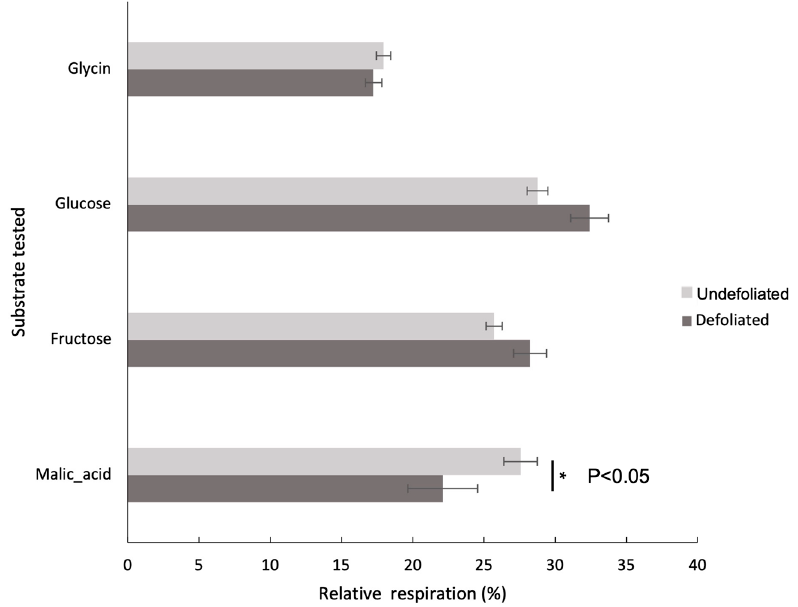
Figure 3. Relative respiration with ± standard error from four different carbon substrate-induced respirations of the top 5 cm of soil under undefoliated (N = 8 white) and defoliated (N = 6 black) Populus tremuloides trees. Tukey’s test found a significative difference between defoliated and undefoliated stand relative respiration only for malic acid as substrate. Soils were sampled in August 2018 in the Lac Duparquet Research and Training Forest (Abitibi, QC, Canada). * p < 0.05 indicates a significant post hoc Tukey contrast.